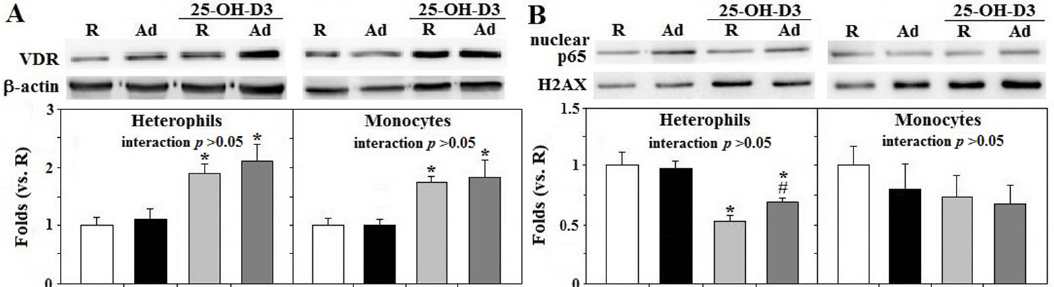
Figure 4. Effects of dietary supplementation of 25-OH-D 3 on VDR protein amounts and p65 activation of leukocytes in broiler breeder hens provided with restricted (R) or ad libitum (Ad) feed intake. Freshly prepared cells from hens at the age of 66 weeks were used for total protein extraction for vitamin D receptor (VDR) expression ( A ) and nuclear extracts were used for p65 (a subunit of nuclear factor kappa B, NF κ B) translocation ( B ) through Western blot method. Results were normalized to β -actin or H2AX and expressed as ratios relative to R-hens ( n = 6). *; significant difference by 25-OH-D 3 , p < 0.05, #; significant difference by Ad-feed intake. 25-OH-D 3 ; 25-hydroxycholecalciferol.